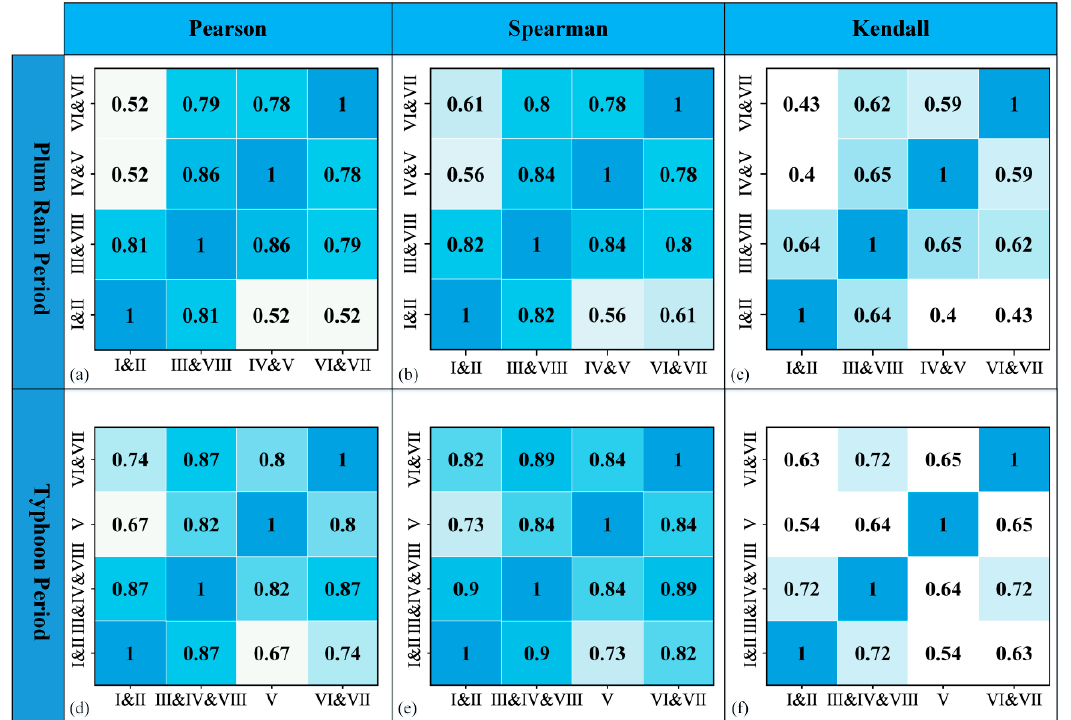
Figure 4. Correlation results of precipitation between eight hydrological regions. (a), (b), and (c) are the results for the plum rain period. (d), (e), and (f) are the results for the typhoon period; (a) and (d) are Pearson correlation results; (b) and (e) are Spearman correlation results; (c) and (f) are Kendall correlation results.